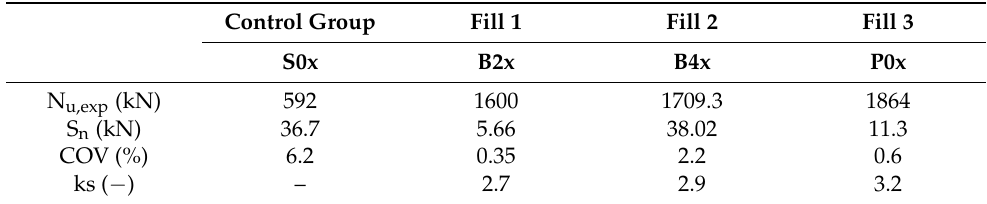
Figure 7. Column models after the experiment. Table 4. Ultimate load forces of column models.